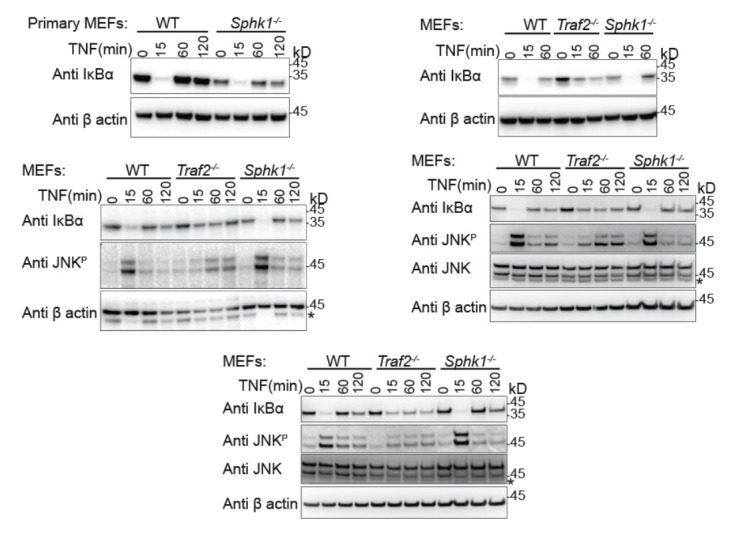
Primary (Top left) and transformed MEFs generated from the indicated knock-out mice stimulated with TNF for the indicated times and Western blotted with the indicated antibodies.These indicate the reproducibility of the results that we have shown in our final manuscript.